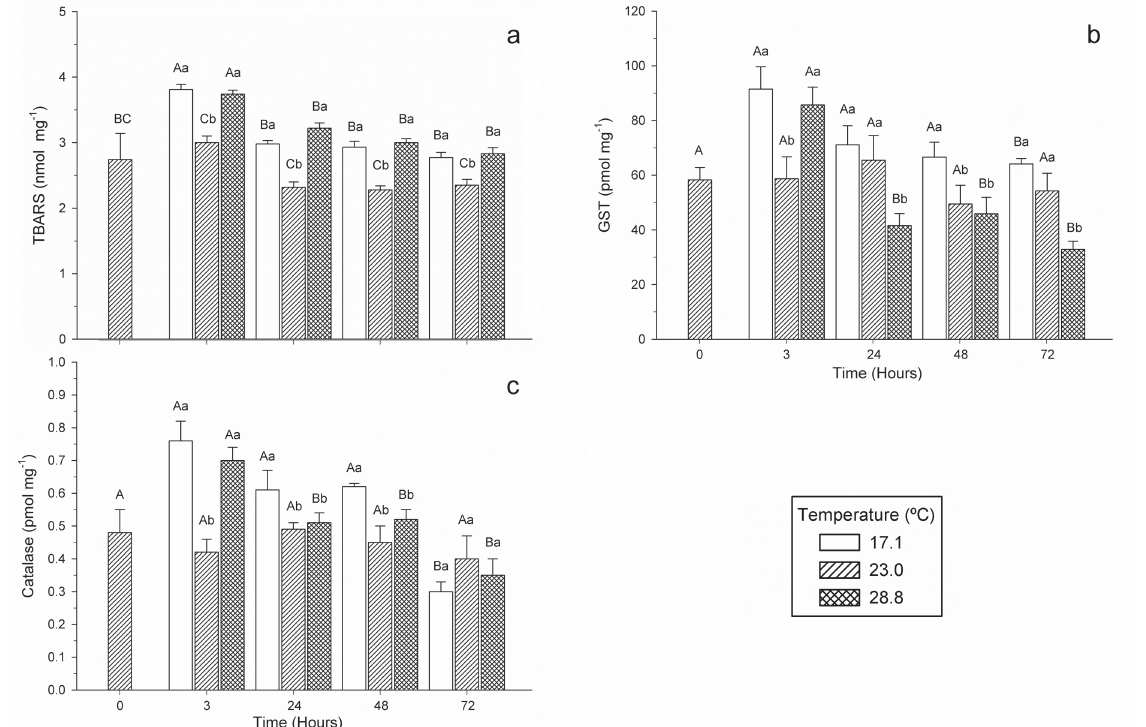
Fig. 2. (TBARS), (GST) and (CAT) activity in the gills of Paralichthys orbignyanus juveniles exposed to different temperatures (17.1, 23.0 and 28.8ºC) as a function of time exposition (72 h). Values are expressed as means ± SEM, N=5. a Lower case letters indicate significantly different at the different temperatures and same time ( P < 0.05), determined by two-way ANOVA and by Dunnet test. A Capital letters indicate significantly different at the same temperatures and different times ( P < 0.05), determined by two-way ANOVA and by Dunnet